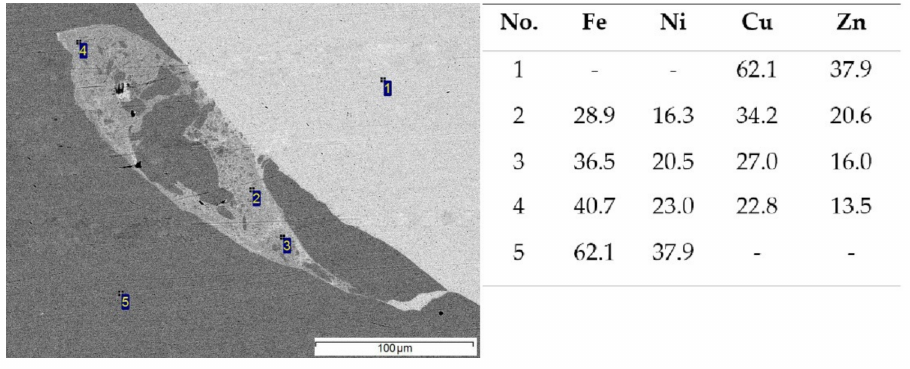
Figure 7. SEM image of a melted zone and the results of point EDS analyses (wt